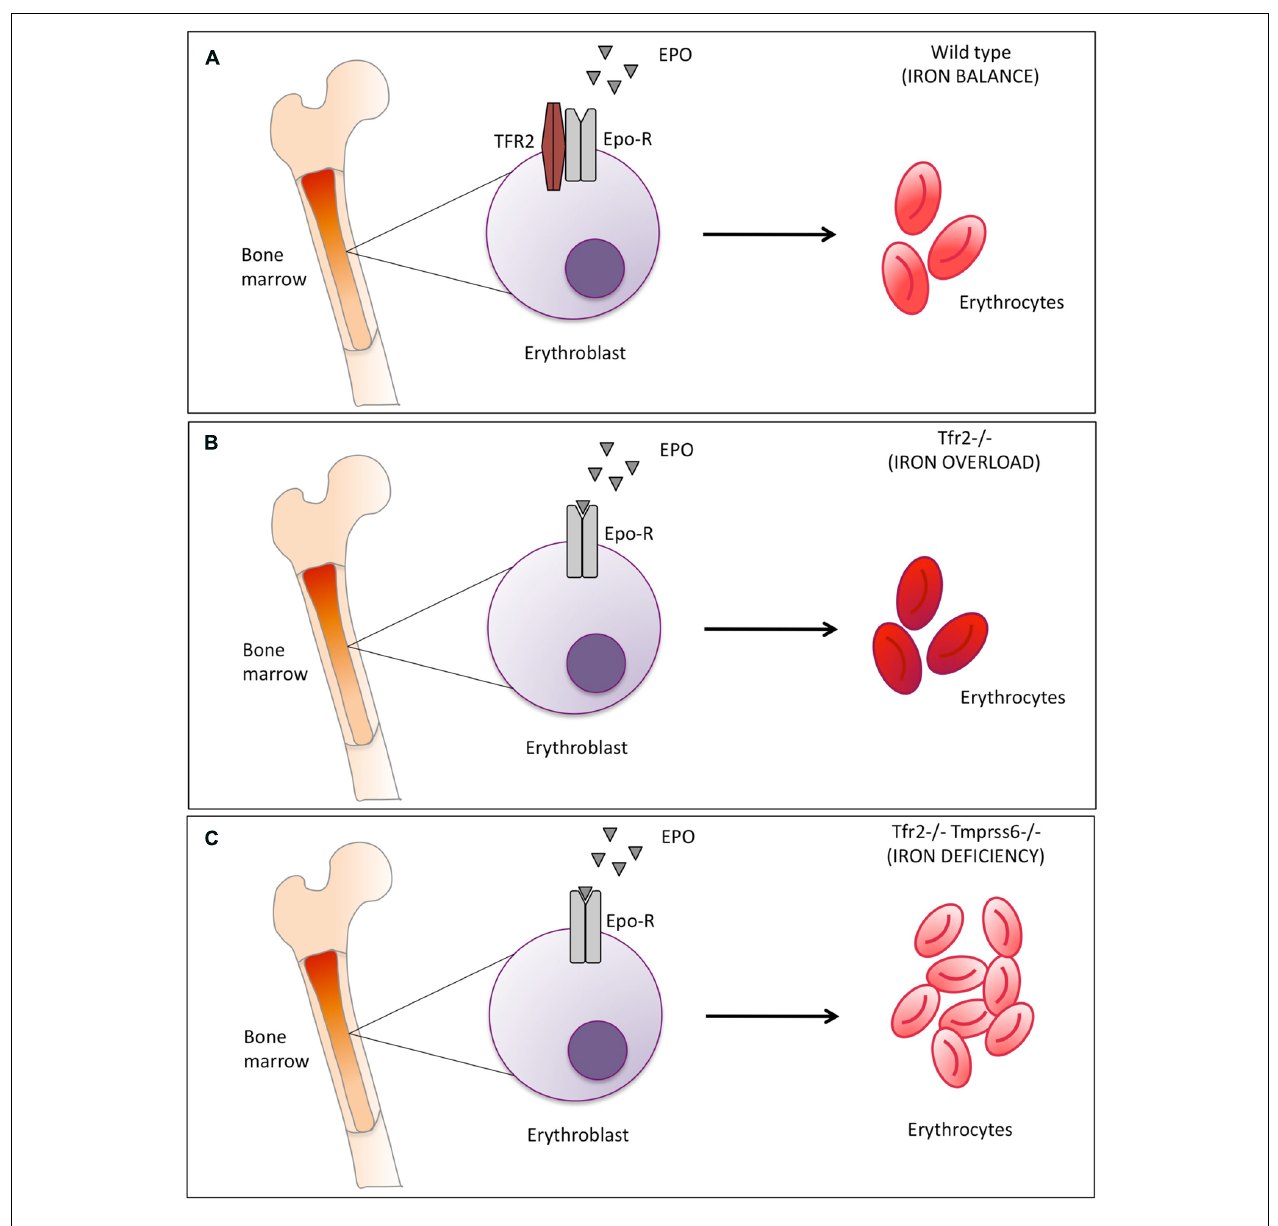
color of the erythrocytes) due to the increased iron availability. (C) Inactivation of Tmprss6 in Tfr2 KO mice increases the number of microcytic erythrocytes, as indicated by the light red color of the erythrocytes. Epo-EpoR interaction occurs in all conditions but is increased in the absence of Tfr2 (panel B and C vs.